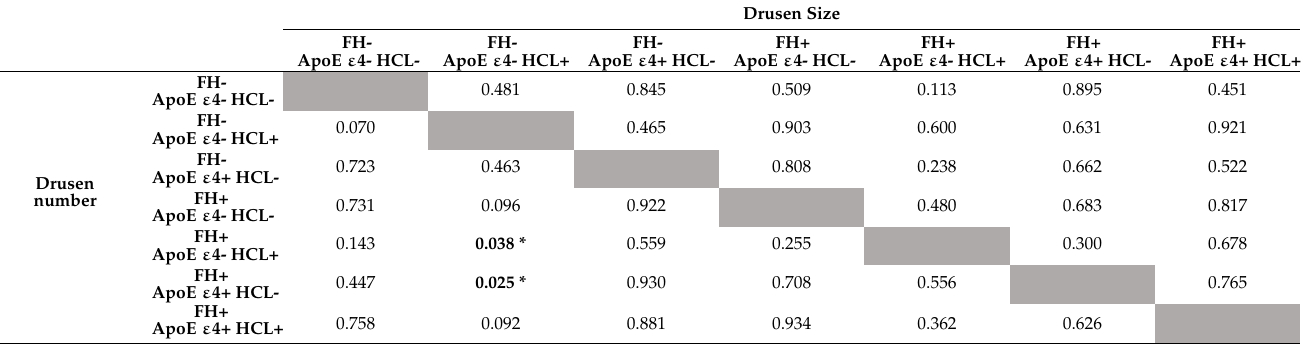
Table 5. p -value of drusen number and size between study groups based on family history, ApoE ε 4- or ApoE ε 4+ genotype, and hypercholesterolemia. Based on Mann–Whitney U Test.